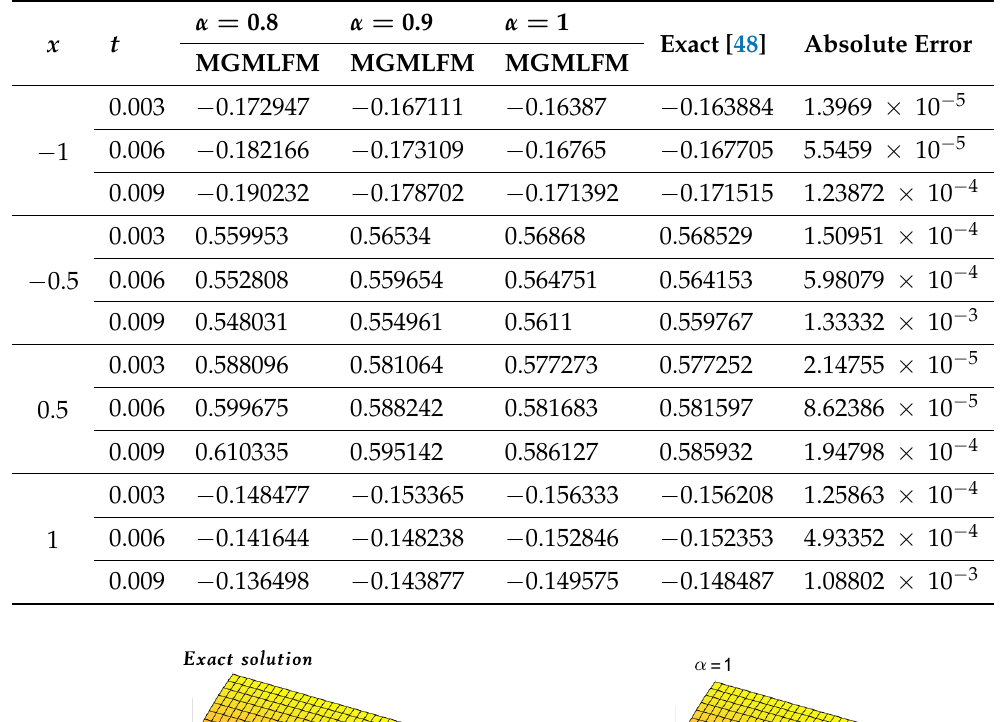
Table 2. Values of approximate solutions obtained by the MGMLFM, exact solution, and absolute errors of V ( x , t ) for system (1) with various values of α , t and x .